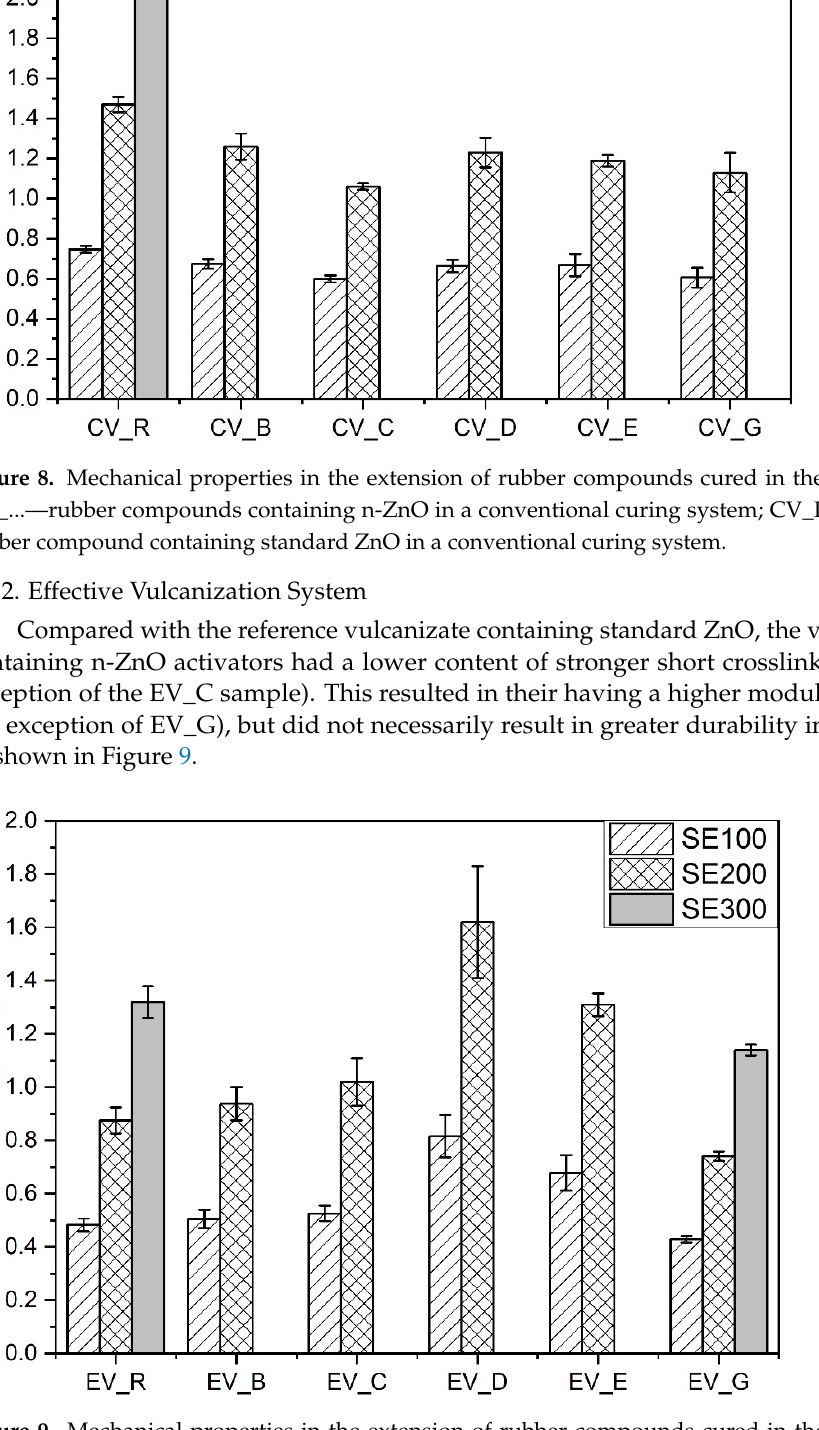
Figure 9. Mechanical properties in the extension of rubber compounds cured in the EV